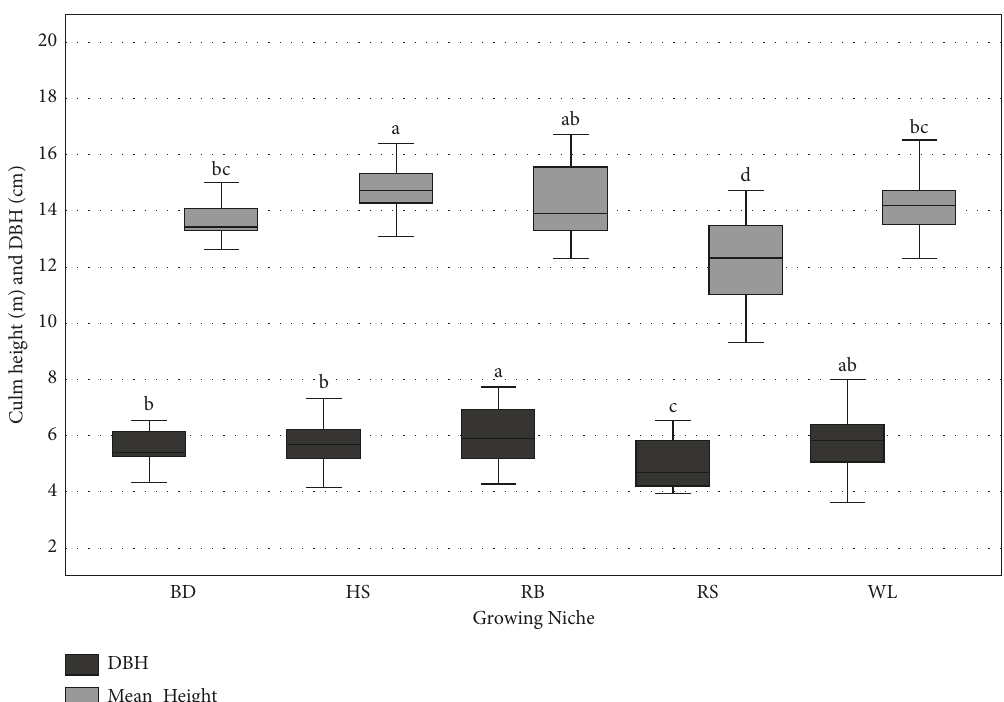
Figure 2: Culm size of highland bamboo (BD � boundary; HS � homestead; RB � river bank; RS � roadside; WL � woodlot plantation niches; values with different letters across bars are significantly different (at α < 0.05)).